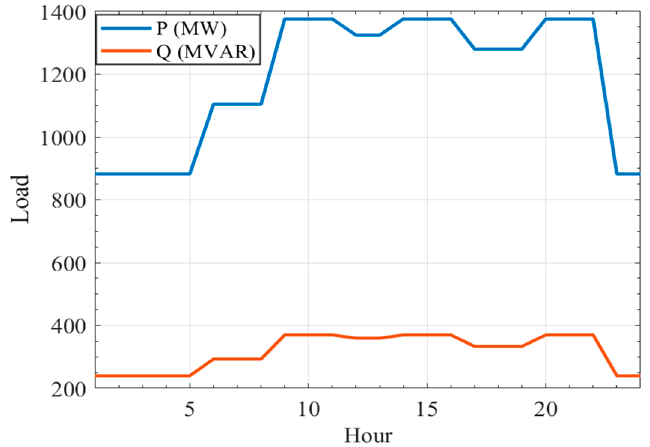
Figure 5. Variations in P and Q in the 57-bus test network.